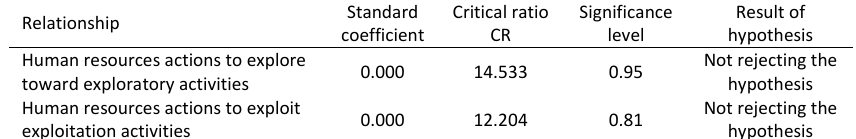
Table 4: Results of hypothesis test Table 4. Results of hypothesis test